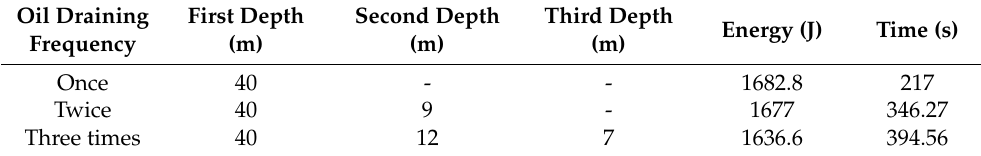
Table 2. Optimisation results based on adaptive genetic algorithm.